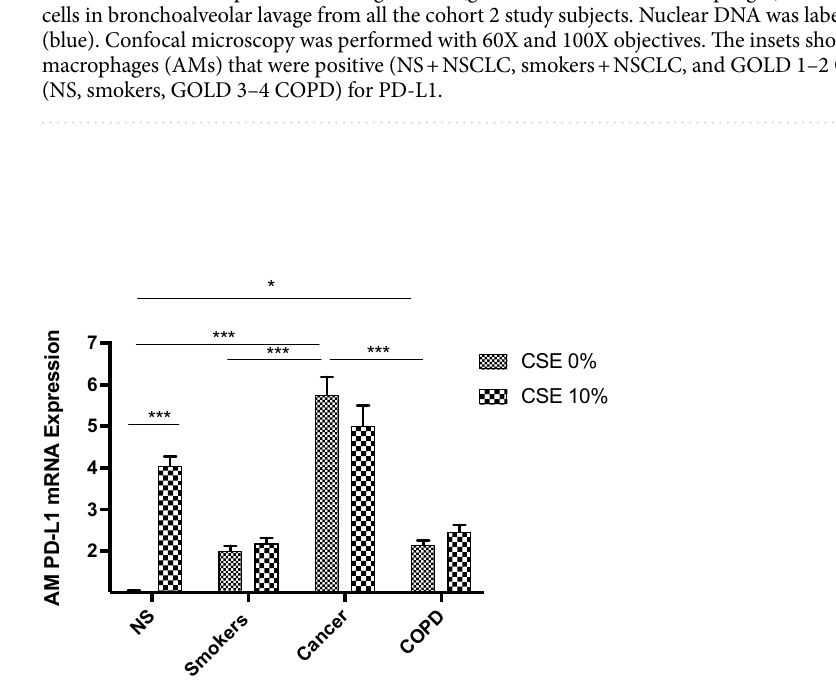
Figure 8. Analysis of PD-L1 mRNA expression levels in AMs from human BAL before and after 10% CSE at 24 h. AMs from BAL all groups were treated with CSE at 10% for 24 h and the expression of PD-L1 mRNA was assessed by real-time RT-PCR. PD-L1 mRNA expression is shown as fold change with respect to 0% CSE. Results were shown as means ± SEM. The statistical tests used in these analyses were one-way analysis of variance followed by Bonferroni’s post-test. * P < 0.05, ** P < 0.01, *** P < 0.001, **** P < 0.0001. NS = Never smokers without cancer or COPD. CSE = cigarette smoke